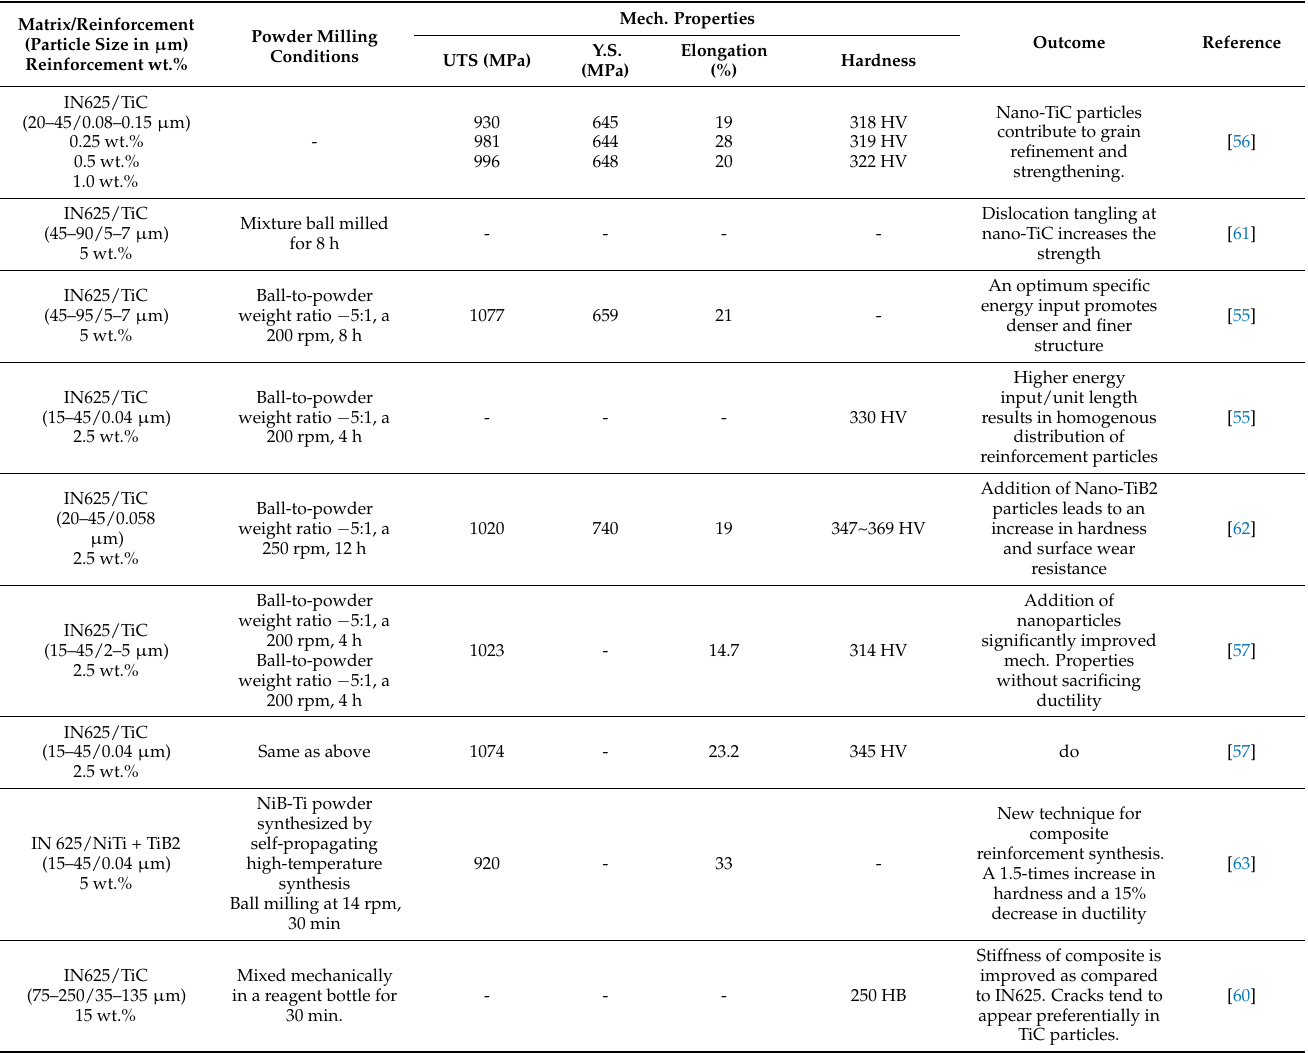
Table 2. Mixing conditions of IN625-based DLD